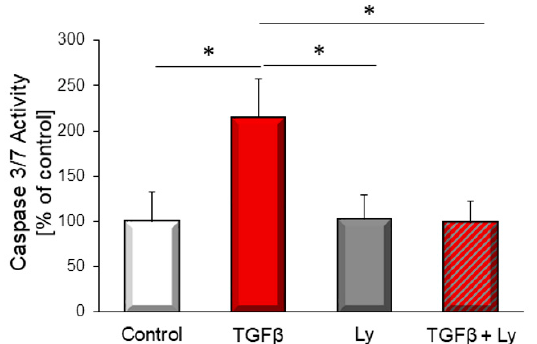
Figure 1. TGF β 1 –induced apoptosis was determined with and without addition of the PI3K inhibitor Ly294002 (10 µ M) by caspase 3/7 activation after six hours stimulation with 1 ng/mL TGF β 1 . Data are shown as means ± SEM of 11 different rat cardiomyocytes preparations. Significance is indicated by * p < 0.05.